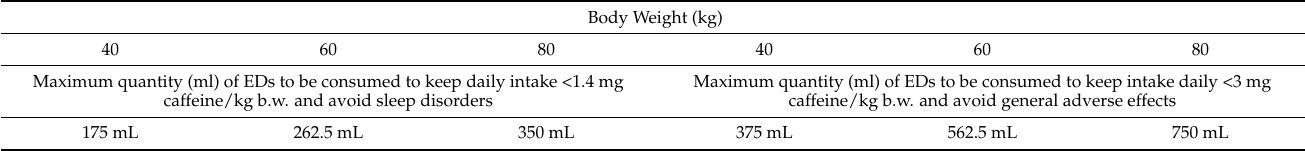
Table 2. Maximum quantities of 32 mg caffeine/100 mL EDs to be consumed (ml) to prevent risks (sleep disturbances and/or general effects on health) derived from the caffeine